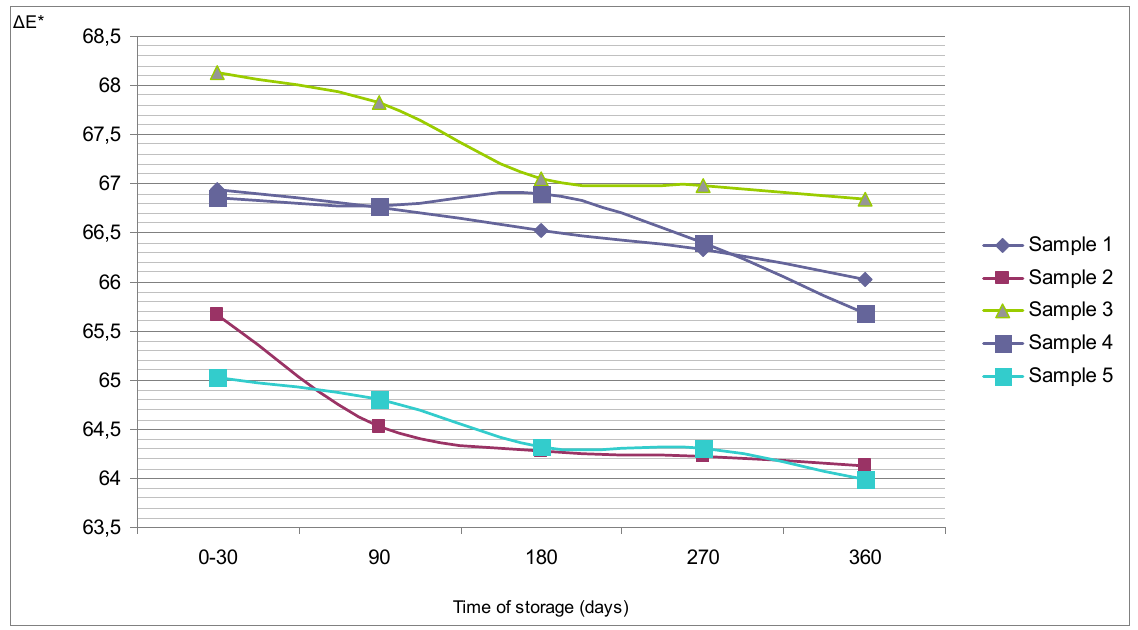
Figure 8. Changes of color difference ( Δ E) on the top surface of samples of dietary chocolates during storage of 360